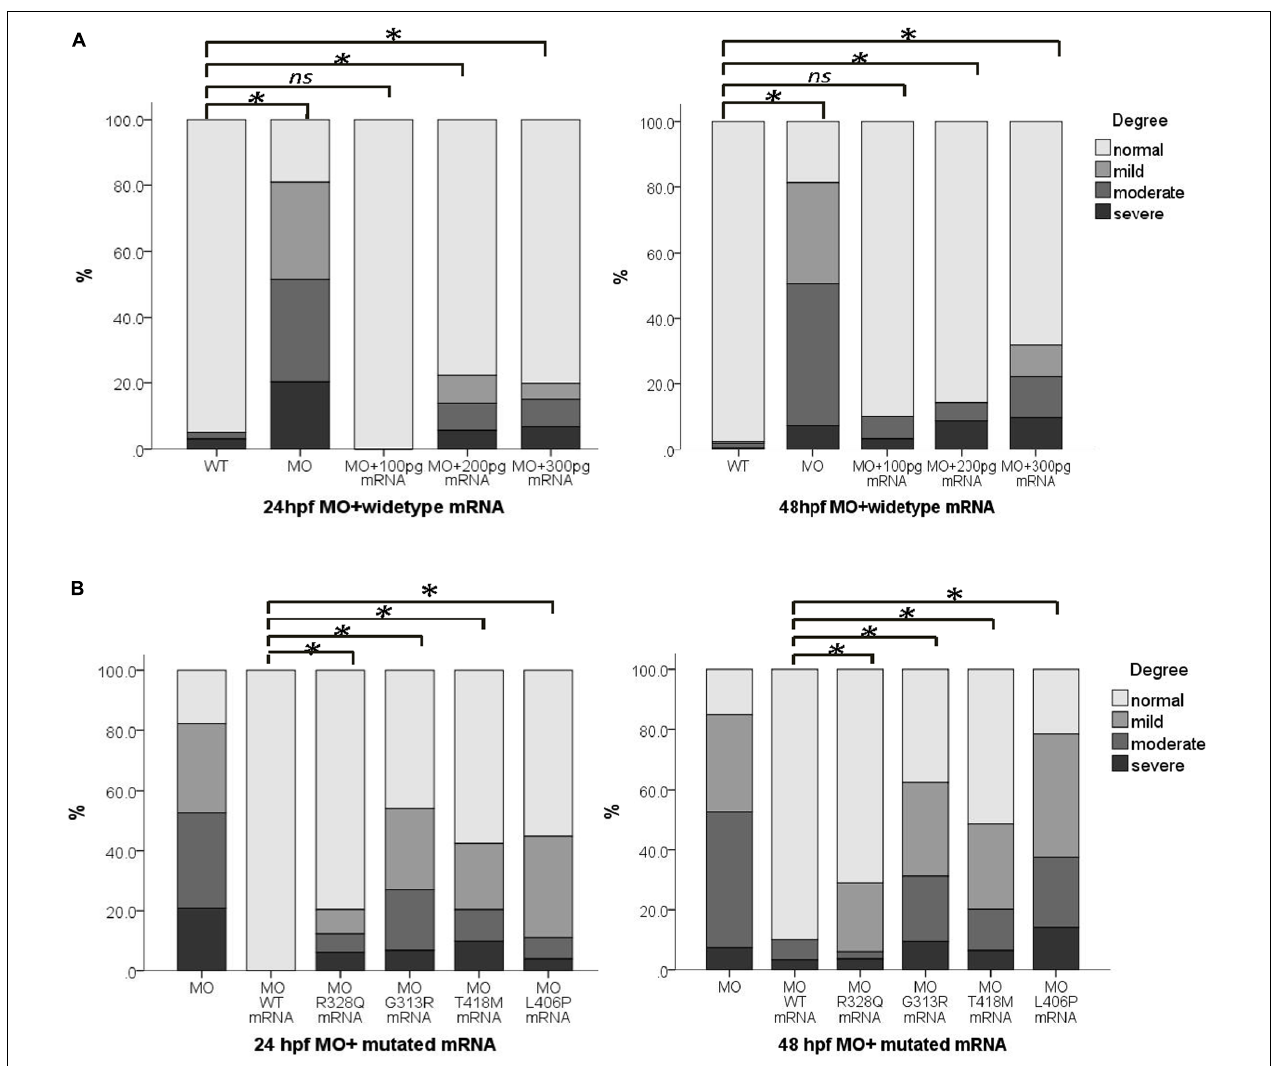
FIGURE 3 | wipi1 mRNA variants affected the convergent extension in zebrafish embryos treated with wipi1 -MO. (A) WIPI1 WT mRNA of 100–300 pg rescued the convergent extension defects induced by co-injection of wipi1 -MO in zebrafish embryos at 24 and 48 hpf. There was no difference in malformation between embryos co-treated with 100 pg mRNA and wipi1 -MO dosage and control embryos untreated with MO or mRNA. (B) WIPI1 mRNA co-injected with wipi1 -MO rescued the convergent extension. However, WIPI1 R328Q, G313R, T418M, or L406P mRNA injection failed to rescue the phenotype, while WIPI1 WT mRNA injection compensated for the phenotype ( ∗ P <